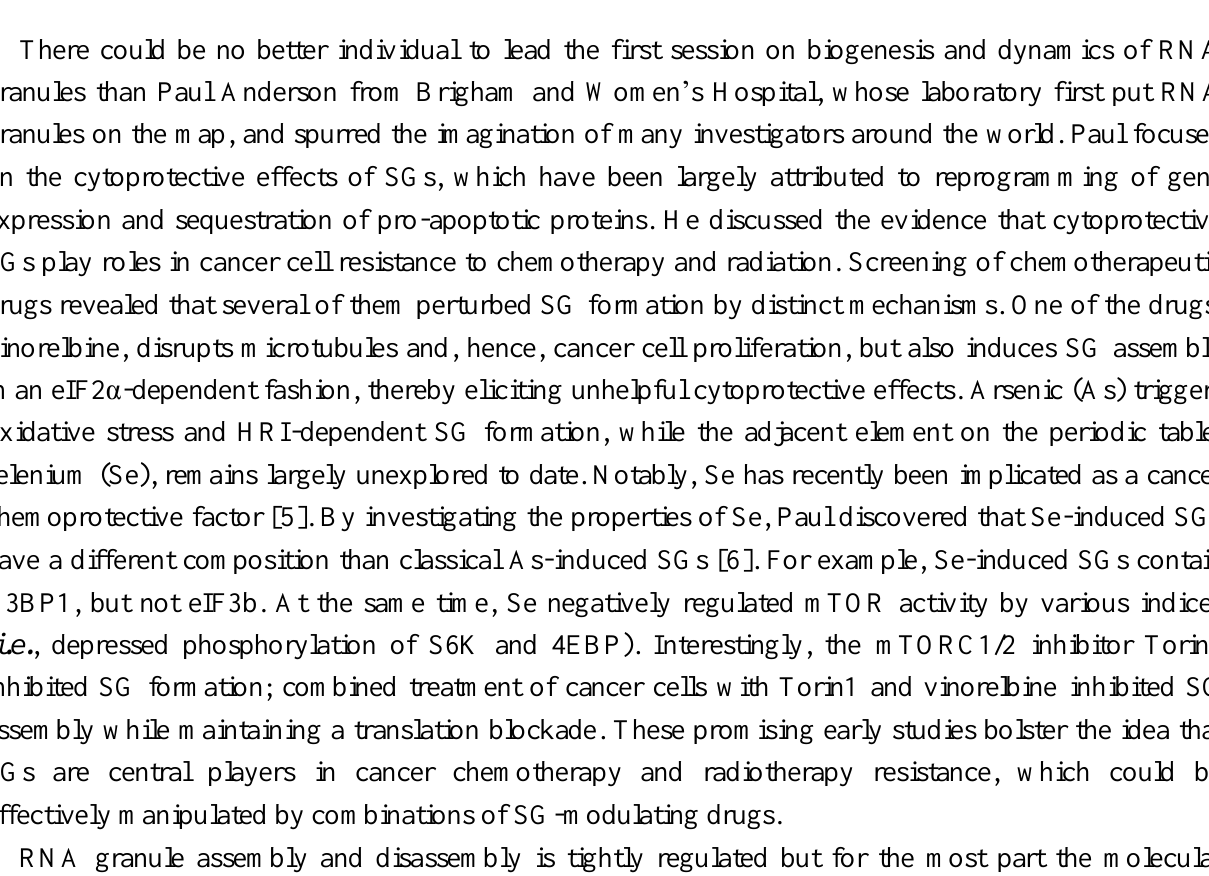
Figure 2. Dr. Richard (Rick) Lloyd ( left ) receives gift following his Keynote Address, a framed photo of the registered heritage property at 2380 Moran Street in Halifax,